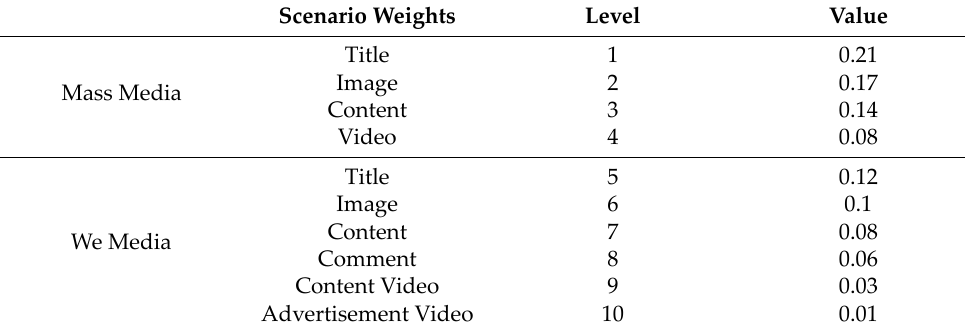
Table 6. The Definition of the Word Scene Coefficient Vector of GREE Electric.